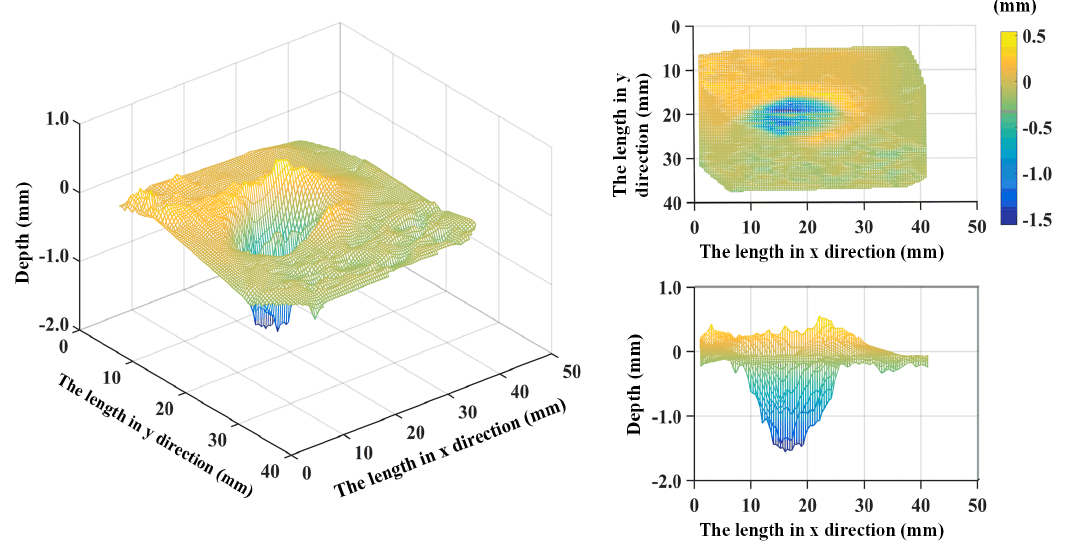
Figure 15. The 3D depth map of the rail surface with the depth information of several experiments.